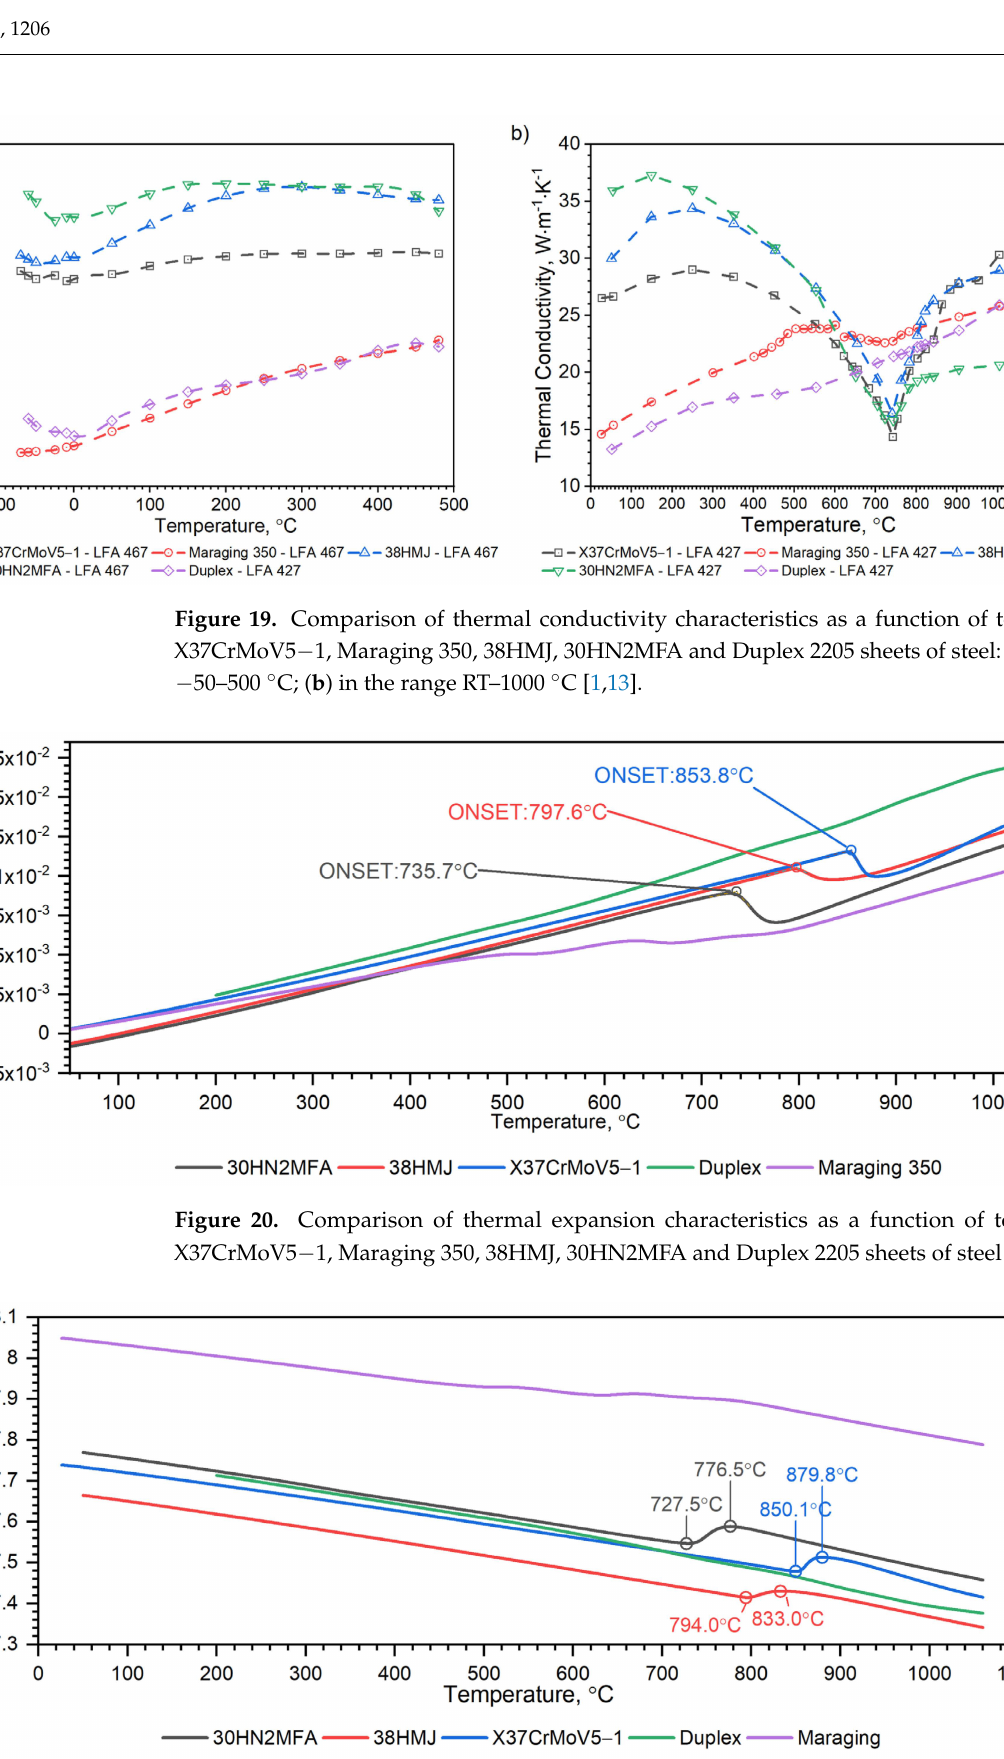
Figure 21. Comparison of density characteristics as a function of temperature for X37CrMoV5 − 1, Maraging 350, 38HMJ, 30HN2MFA and Duplex 2205 sheets of steel